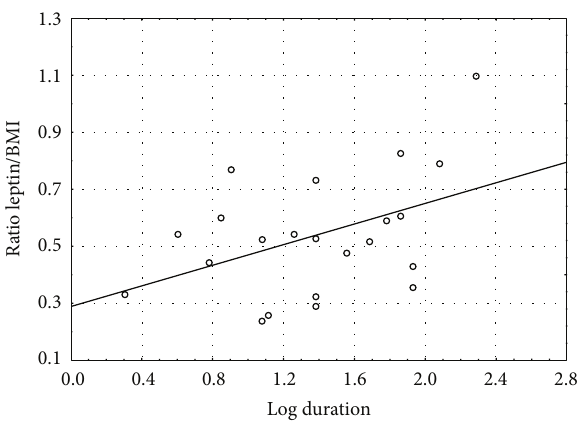
Figure 1: Correlation of the ratio leptin/BMI to duration of illness (in months, after logarithmic transformation) in female patients with relapsing-remitting MS ( 𝑛 = 22 ; 𝑟 = .4368 ; 𝑃 = .04